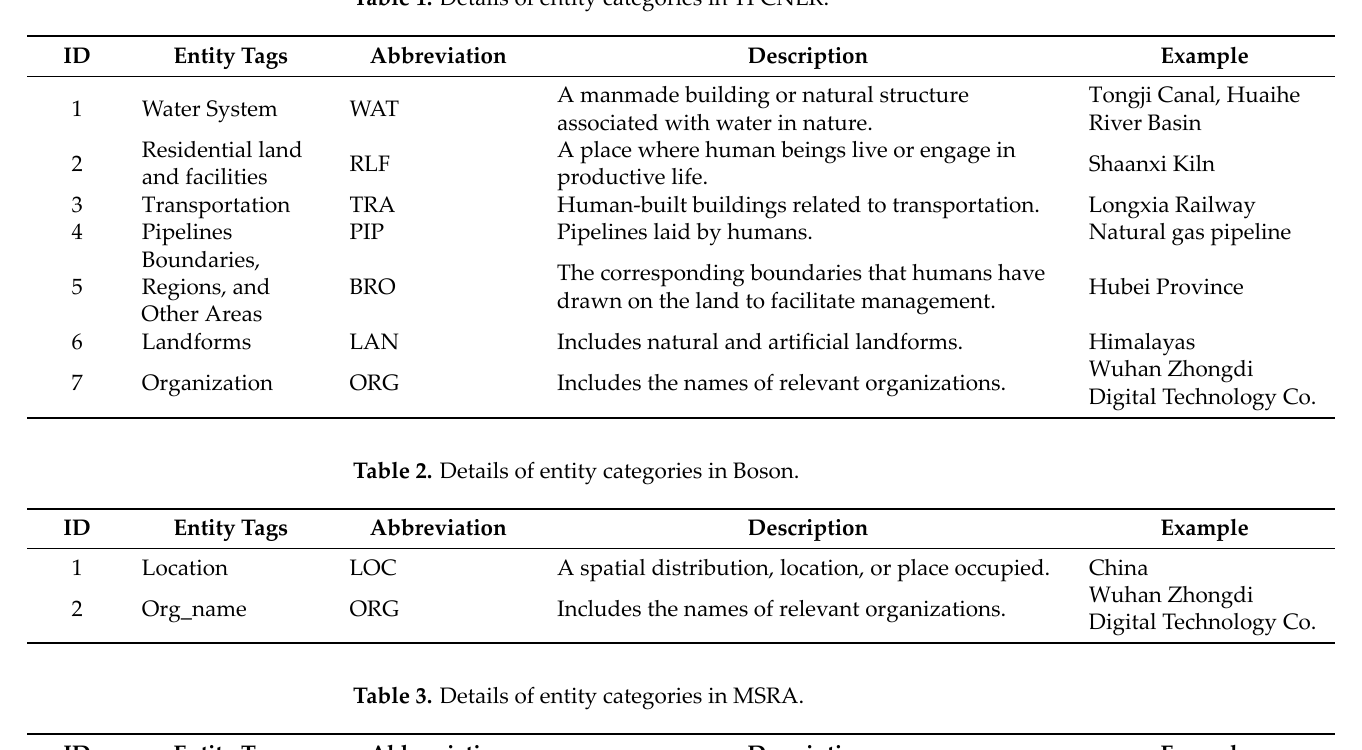
Table 1. Details of entity categories in TPCNER.